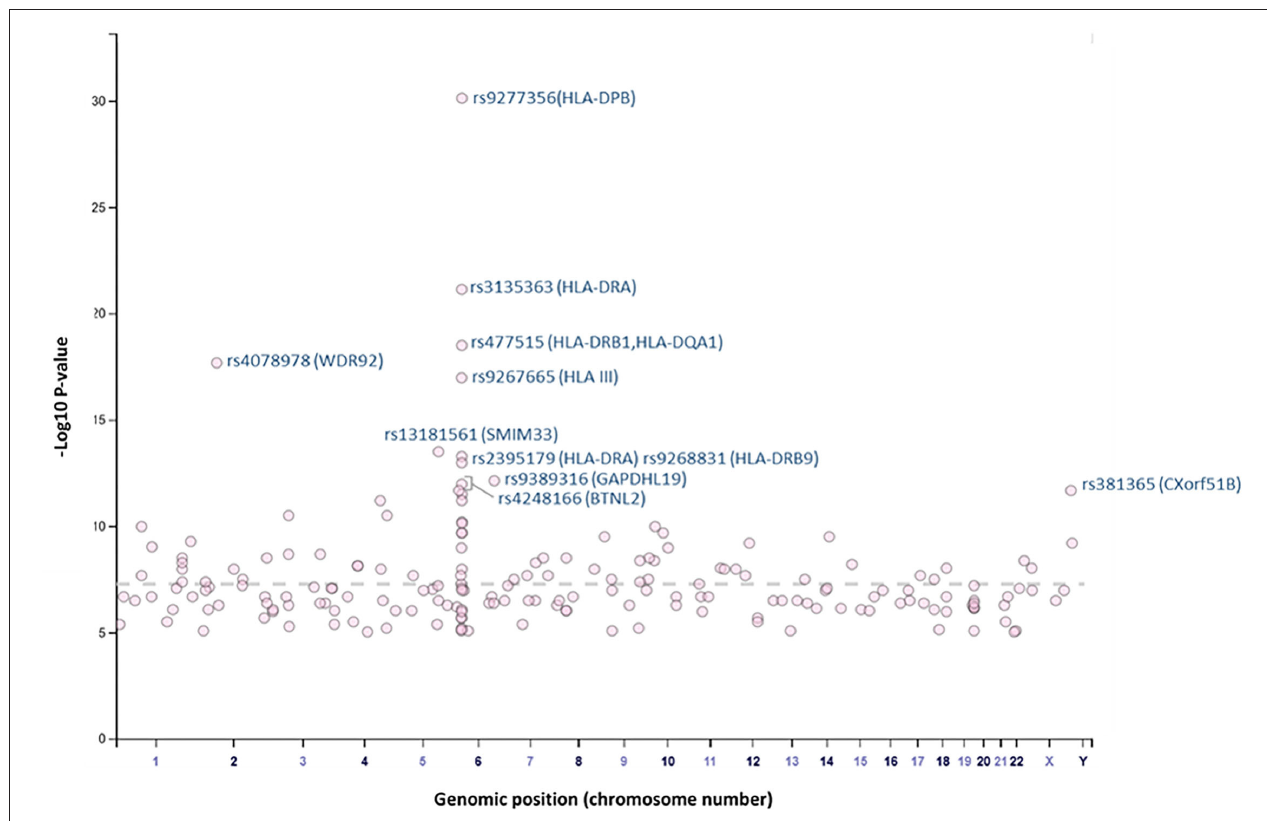
FIGURE 2 | Plot of GWAS Catalog associations for vaccine response related SNPs. The data and plot were retrieved from the GWAS catalog, an open database. All associations with “response to vaccine” phenotype are plotted. The top 10 SNPs are labeled with the rs